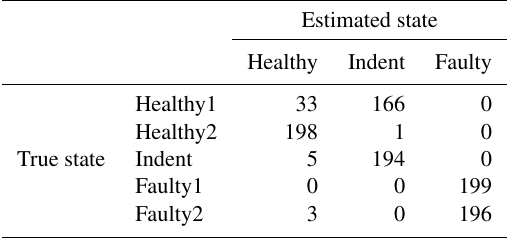
Table 2. Confusion matrix for 1500rpm PCB data and the top four features.